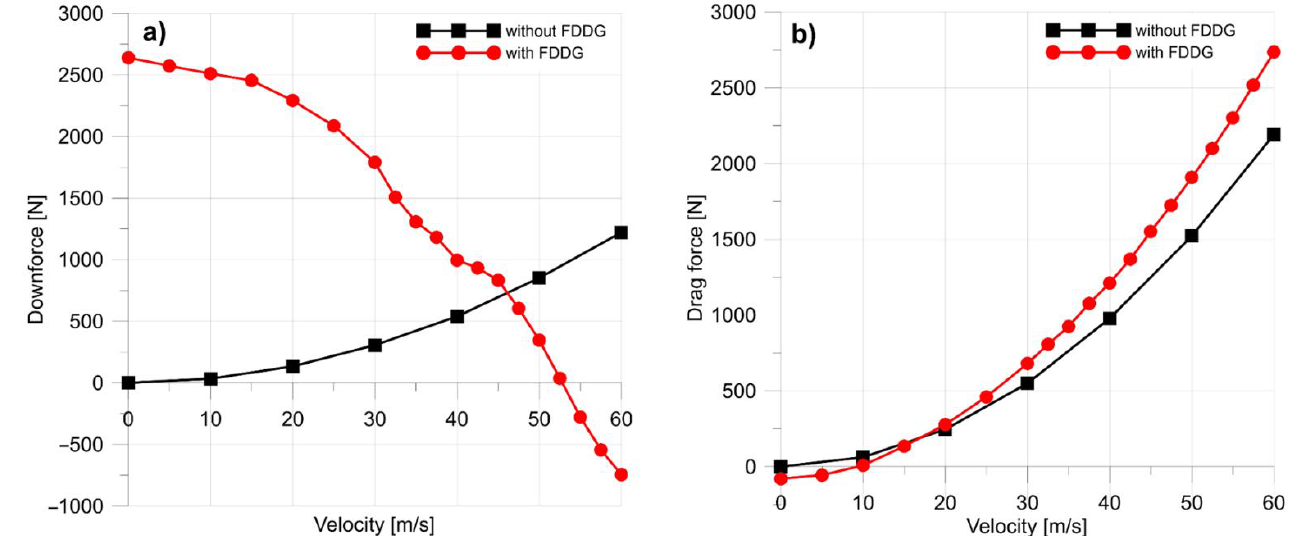
Figure 23. Aerodynamic forces for the baseline case and the case with FDDG for various inlet speeds: ( a ) Downforce; ( b ) Drag force.